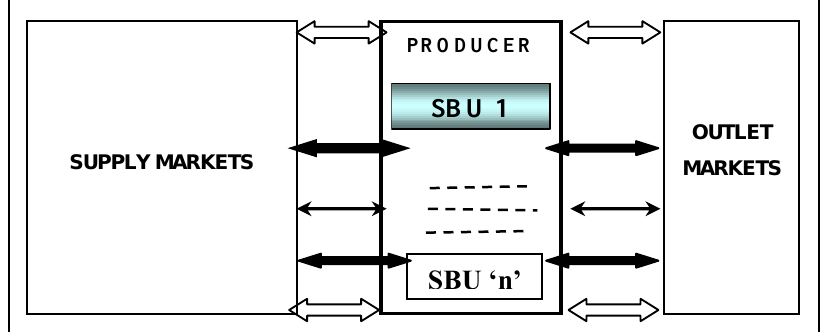
Localization Choices in Markets Characterized by Unstable Equilibrium Between Supply and